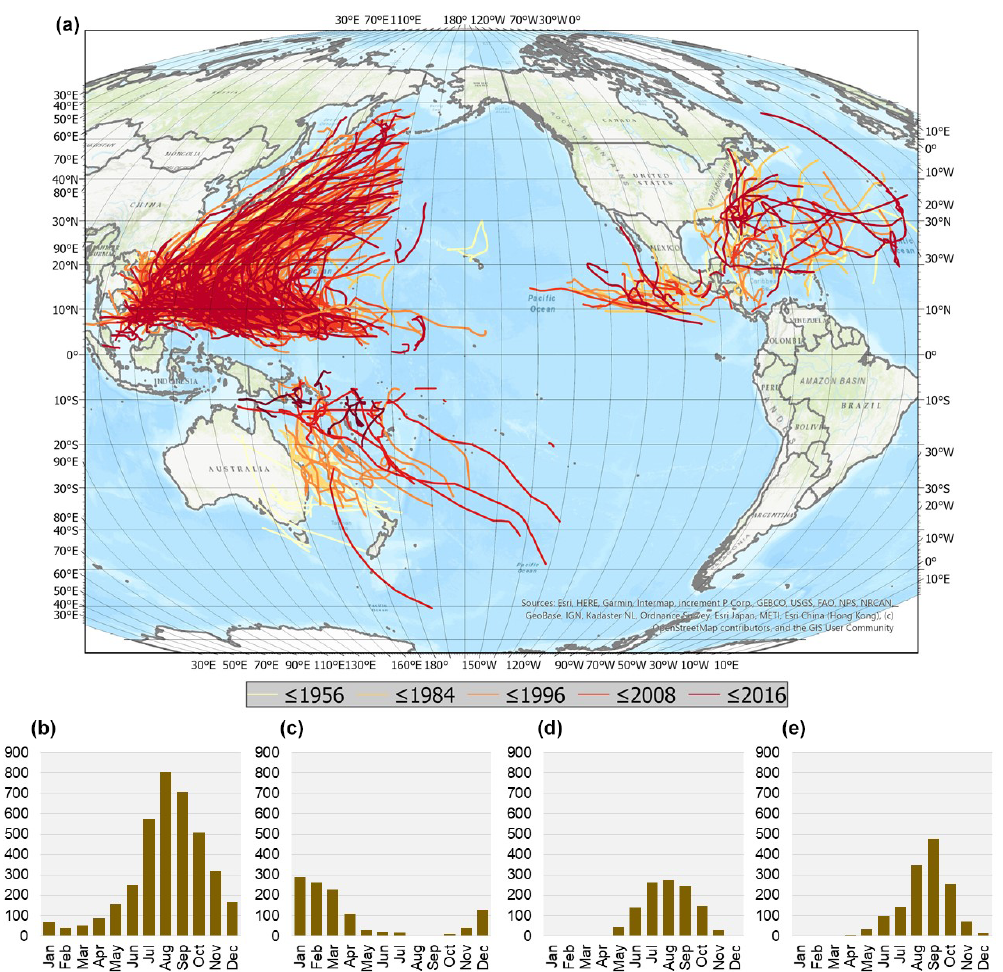
Figure 1. Tracks of all off-season TCs (a) and the number of storms per month for the WP (b) , SP (c) , EP (d) and NA (e) basins for the 1900–2019